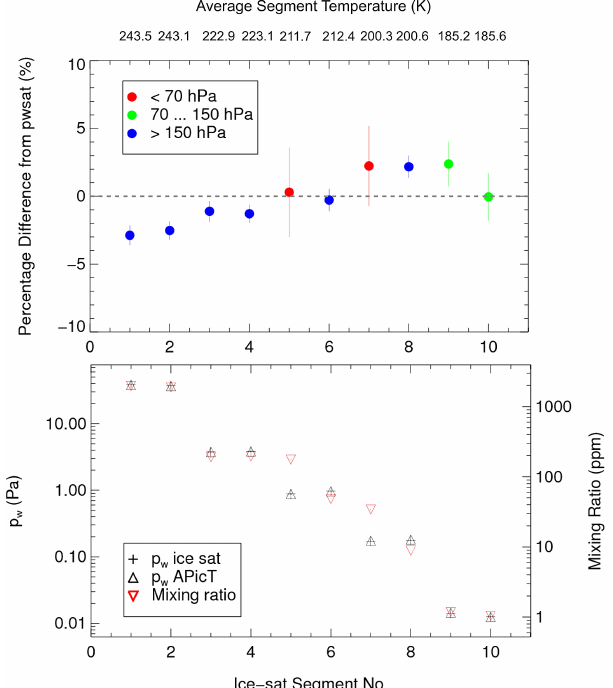
Figure A2. Top: differences between APicT water vapor partial pressures and those calculated from ice saturation at measured temperatures (top axis) for AquaVIT-1 dynamic experiment seg- ments. Bottom: water vapor partial pressures versus dynamic seg- ment number as calculated ( p w ice sat) and as measured by APicT ( p w APicT). Also shown are water vapor mixing ratios in the cham- ber (right-hand axis).